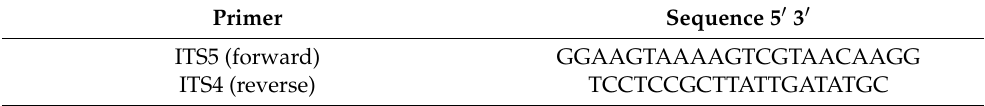
Table 7. The ITS primer pair was used in the PCR reactions to amplify the ITS region.